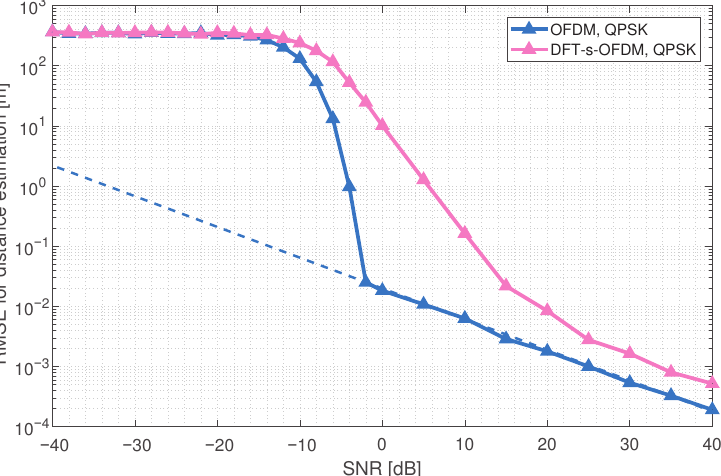
Figure 3. Comparison of the RMSE for distance estimation between OFDM and DFT-s-OFDM.